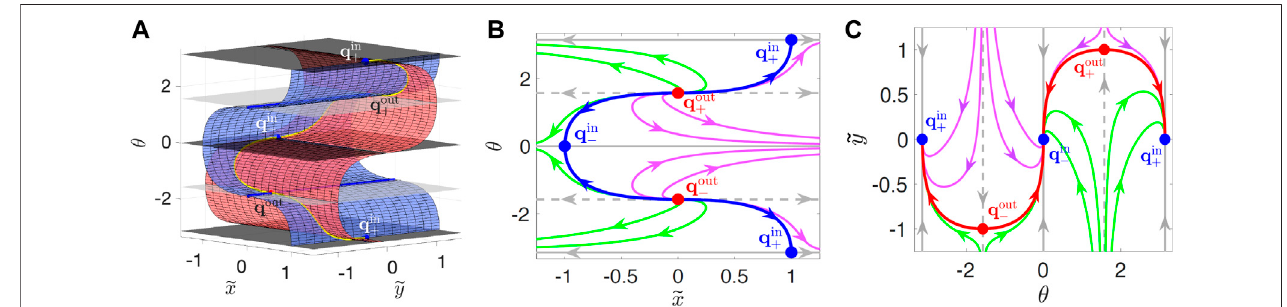
FIGURE3| Manifoldsin ( ~ x , ~ y , θ ) spacefor α =1(fromRef.[34]). (A) Swimminginvariantmanifoldsinthree-dimensional ( ~ x , ~ y , θ ) space.Theblueshadedsheetisthe stable manifold of the two inward-blocking swimming fi xed points q in , and the red shaded sheet is the unstable manifold of the outward-blocking points q out . (B) Projectionofthestable manifoldof q in into ( ~ x , θ ) space. (C) Projection oftheunstable manifoldof q out into ( ~ y , θ ) space.Thegreenand magenta curvesshowprojections of trajectories in the phase space.